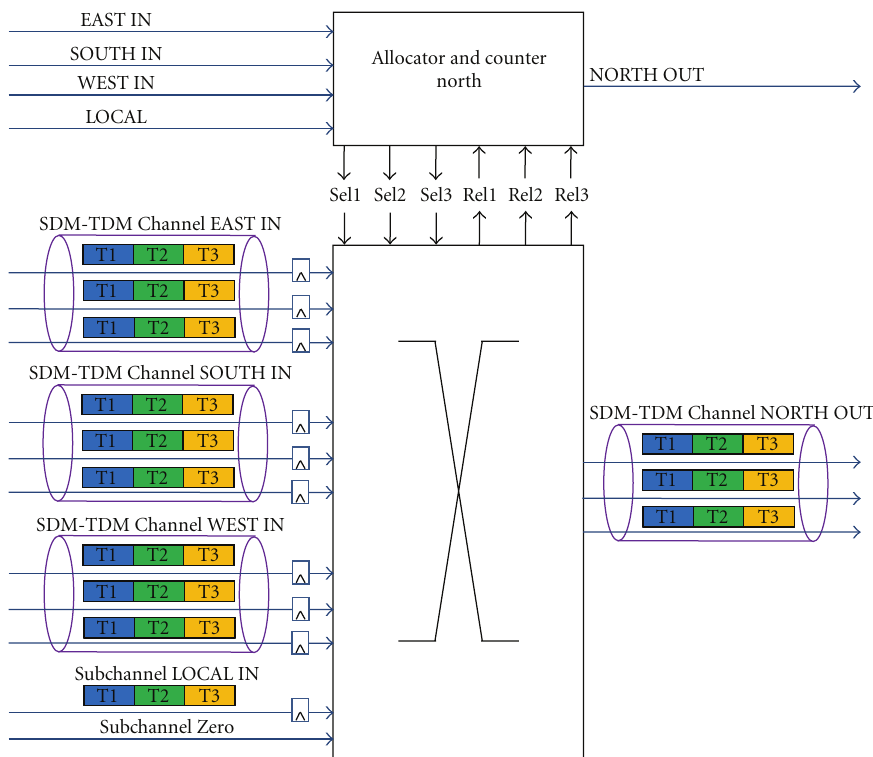
Figure 23: Block diagram SDM-TDM Switch